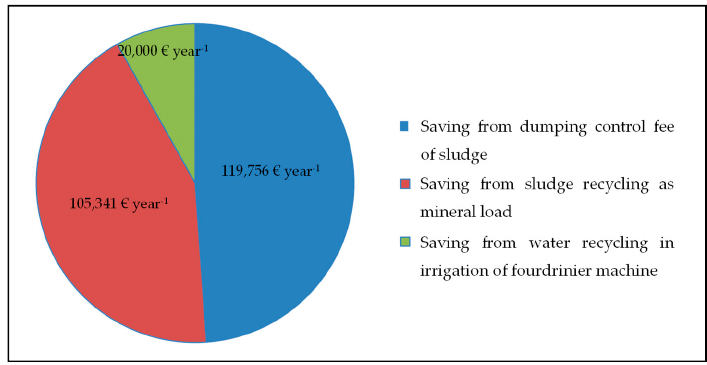
Figure 4. Distribution of savings from the recycling of sludge and water within the circular economy model.